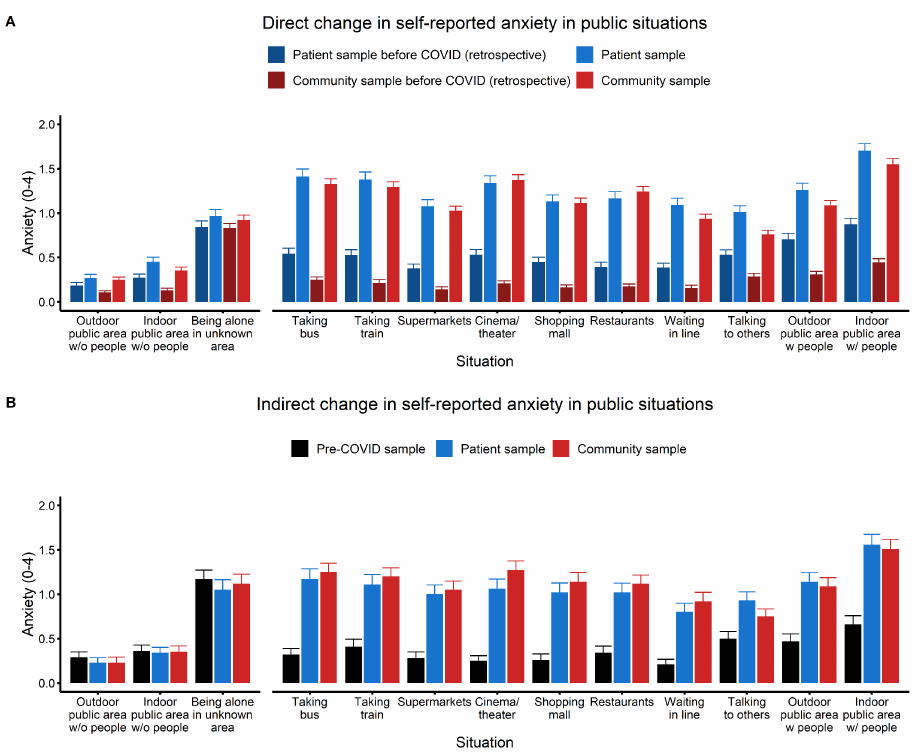
Average Self-Reported Anxiety in Selected Public Situations Before and During the COVID-19 Pandemic (With Standard Error of the